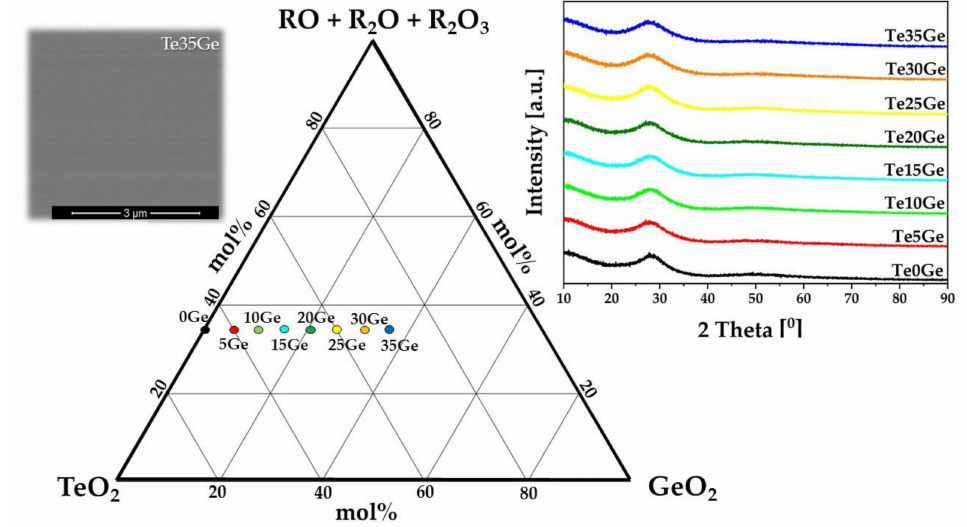
Figure 1. Glass-formation region of TeO 2 /GeO 2 –Ga 2 O 3 -BaO-ZnO-Na 2 O-Eu 2 O 3 system at 1100 ◦ C (in mol%). Diffraction patterns of glasses and SEM photo for Te35Ge glass (inset).